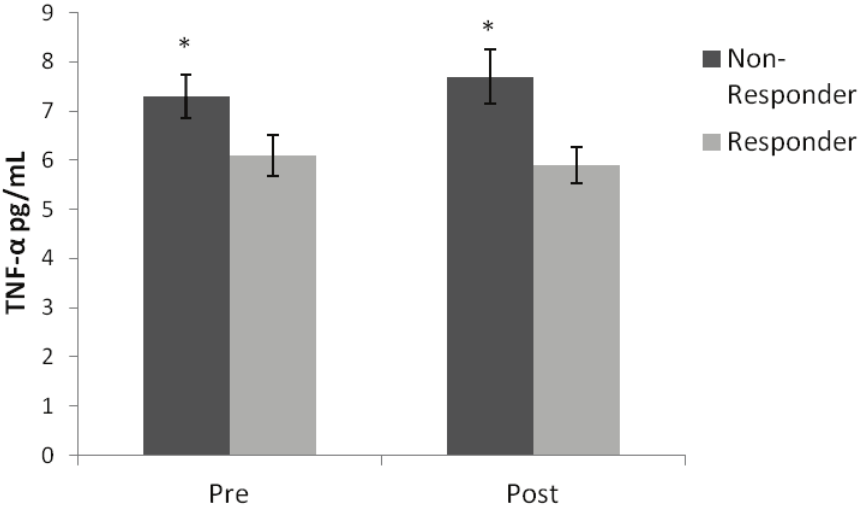
Figure 1. * Significantly greater concentration of circulating TNF- α in fat -free mass non-responders compared to responders ( p <